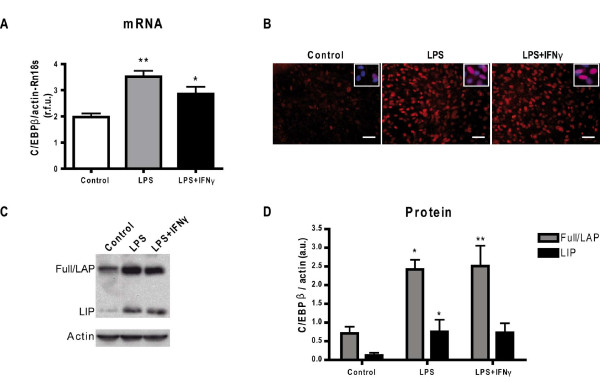
C/EBPβ expression in activated mixed glial cultures. Effect of 100 ng/mL LPS alone or in combination with 0.1 ng/mL IFNγ on C/EBPβ expression in secondary mixed glial cultures. A. C/EBPβ mRNA expression is upregulated in glial activation. Cultures were treated with LPS and LPS+IFNγ for 6 h and mRNA was analyzed by qPCR. Results are expressed as relative fold units (r.f.u.) of ΔΔCt values between C/EBPβ and actin + Rn18s as reference genes. One-way ANOVA followed by Dunnett's test is applied. *p < 0.05; **p < 0.01 compared to control. (n = 3). B. LPS and LPS + IFNγ (24 h) increase nuclear C/EBPβ immunostaining (red) in secondary mixed glial cultures. In the right upper corner, a detail shows overlapping between Hoechst 33258 nuclear staining and C/EBPβ. Images are representative of 5 independent experiments. Bar = 50 μm. C. A western blot shows levels of C/EBPβ in secondary mixed glial cultures treated with LPS or LPS + IFNγ for 24 h. The C/EBPβ isoforms are identified as Full/LAP and LIP. β-Actin is used for normalization. This experiment was done 4 times with similar results. D. Full/LAP (grey bars) upregulation after LPS and LPS+IFNγ is statistically significant compared to control. LIP (dashed bars) upregulation is statistically significant only for LPS treatment. One-way ANOVA, followed by Dunnett's test is applied. *p < 0.05; **p < 0.01 compared to respective control. (n = 4-5)